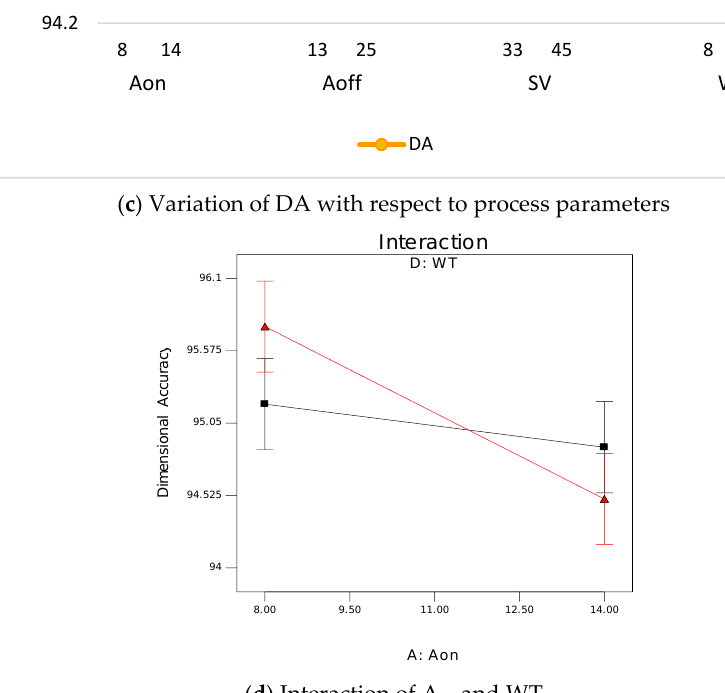
Figure 3. Summary of process parameters with respect to dimensional accuracy.